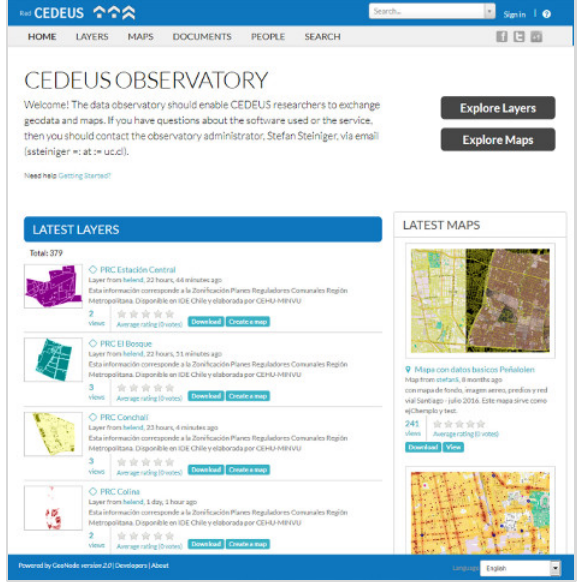
Figure 4. The Geoportal of the “CEDEUS Observatory” based on the software GeoNode 2.0, offering options to explore, search, download and upload geographic data and (non- geographic) documents.